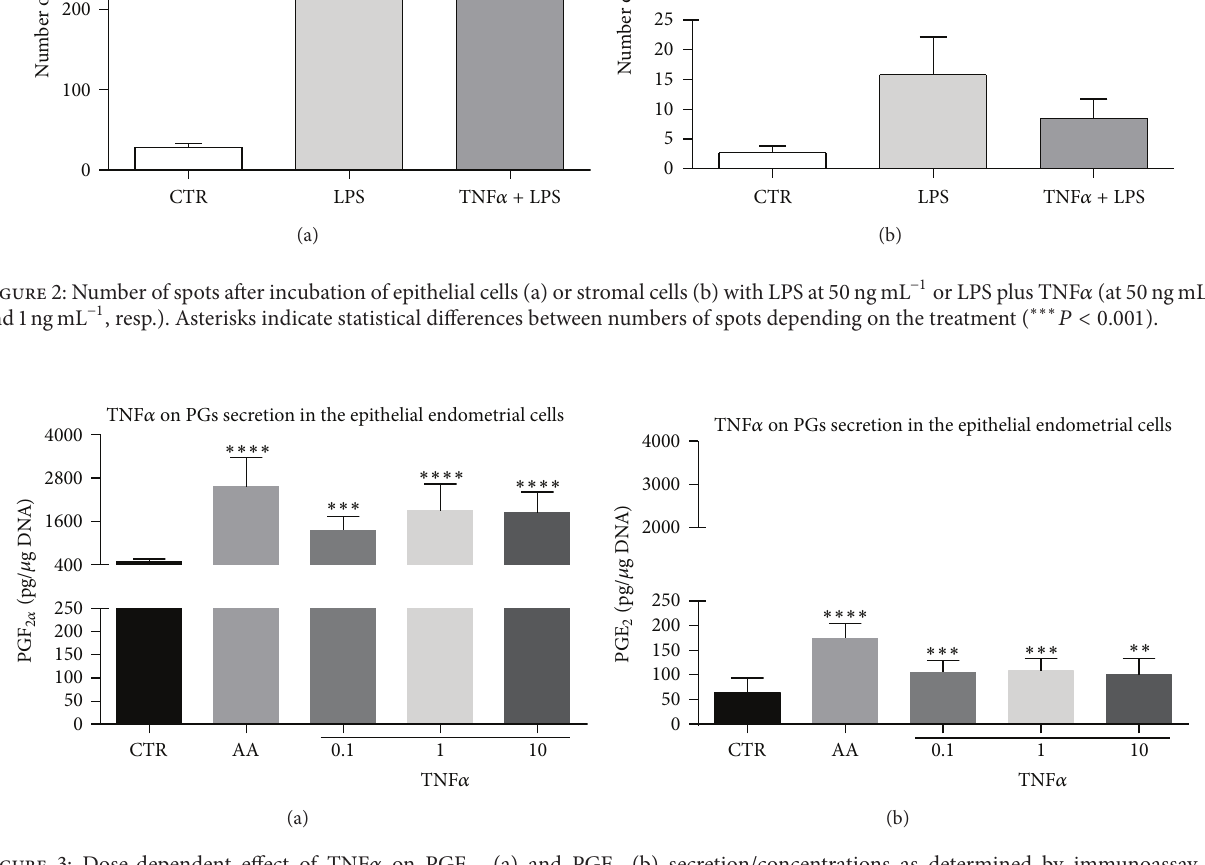
Figure 3: Dose-dependent effect of TNF 𝛼 on PGF 2𝛼 (a) and PGE 2 (b) secretion/concentrations as determined by immunoassay in endometrial epithelial cells (surface and glandular epithelium). Asterisks indicate statistical differences between prostaglandin (PG) levels depending on the treatment ( ∗∗ 𝑃 < 0.01 , ∗∗∗ 𝑃 < 0.001 , and ∗∗∗∗ 𝑃 < 0.0001